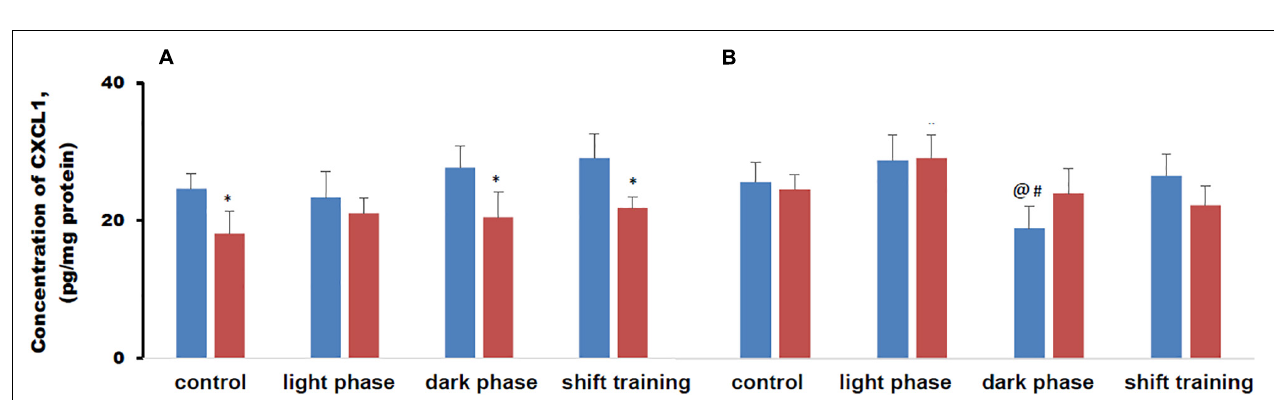
FIGURE 7 | Concentration of leukemia inhibitory factor (LIF) in mice muscle tissue (pg/mg protein). Panel (A) shows young-age mice. Panel (B) shows old-age mice. Blue columns represent Chow diet and red columns represent High fat diet. Data are presented as the mean ± error of the mean. *Significantly different ( p < 0.05) from Chow diet. #Significantly different ( p < 0.05) from young-age mice. @Significantly different ( p < 0.05) from control.